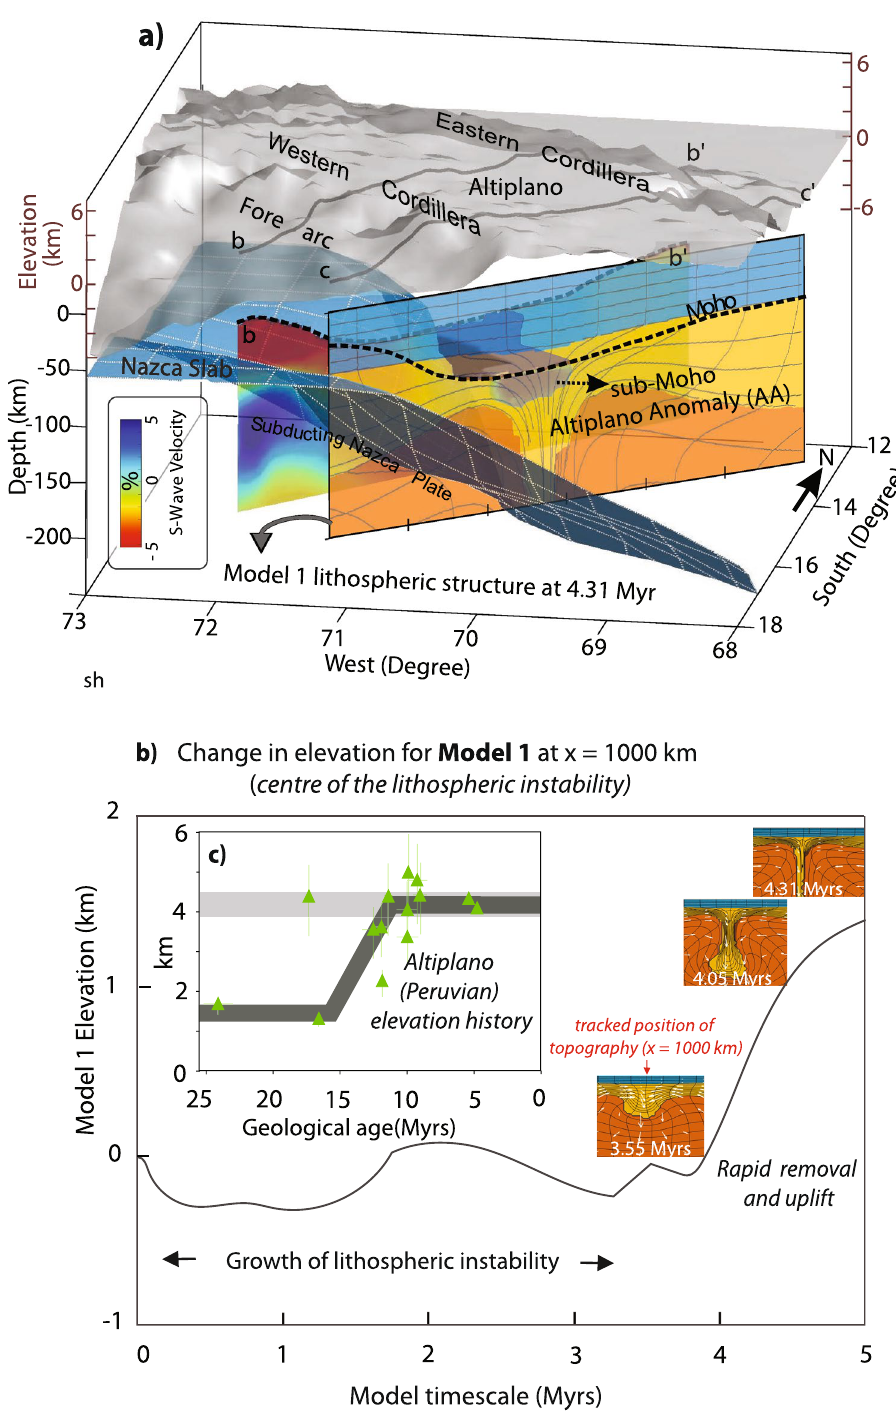
Figure 4. ( a ) S-wave velocity distributions across Peruvian part of Central Andes 18 where high seismic wave speed (sub-Moho Altiplano anomaly) is shown over two cross sections ( b – b ′ and c – c ′ ). Numerical model result (Model 1) for 4.31 Myrs is reconciled with the inferred lithospheric structure derived from seismic analyses. The Moho (from Fig. 1c) in all cross-sections is shown as a dashed black line, isosurface of the subducting Nazca Slab is derived from the Slab 1.0 60 . Figure is created through Matlab software version R2016b (https:// www. mathw orks. com/), ( b ) Predicted trajectory of topography for Model 1 above the lithospheric drip (x = 1000 km), ( c ) Paleoelevation estimates of the Altiplano region compilted from 14